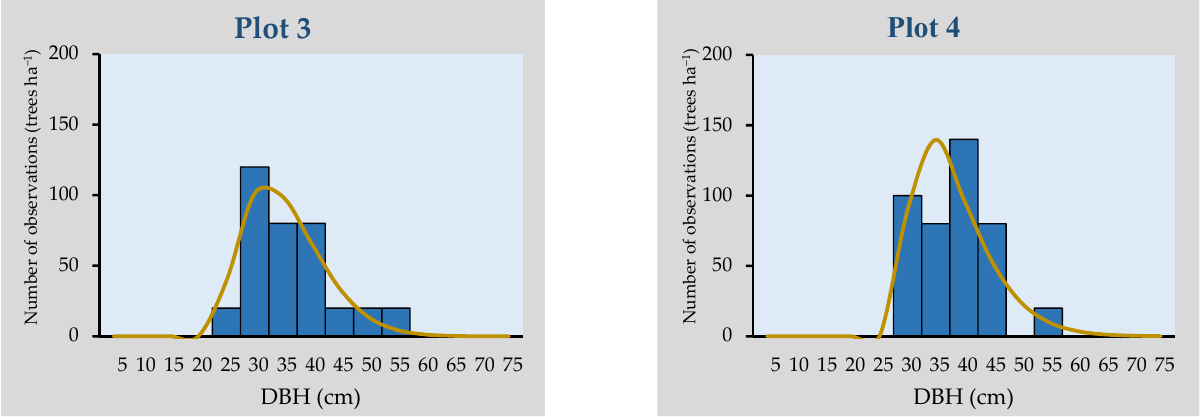
Figure 3. The relationship between the observation (bar) and predicted curve (line) for all plots.